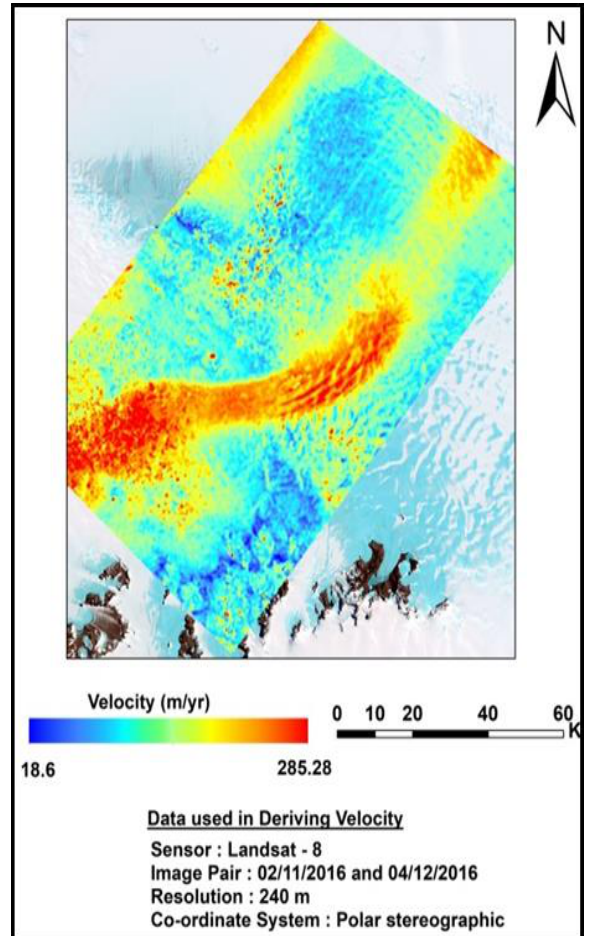
Figure 3. Derived Velocity